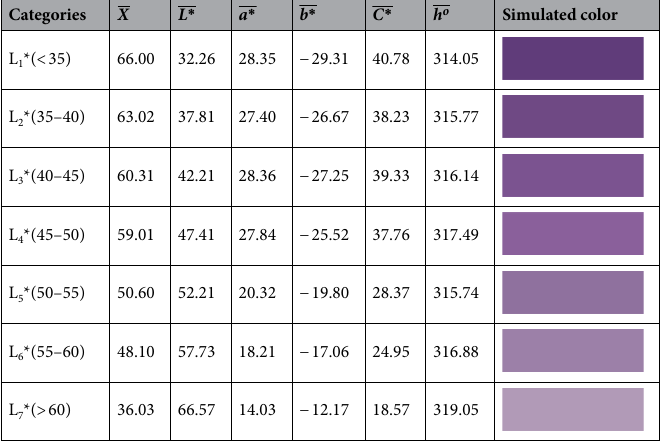
Table 2. The average peak area ( X ) at 545 nm and average color parameters of 7